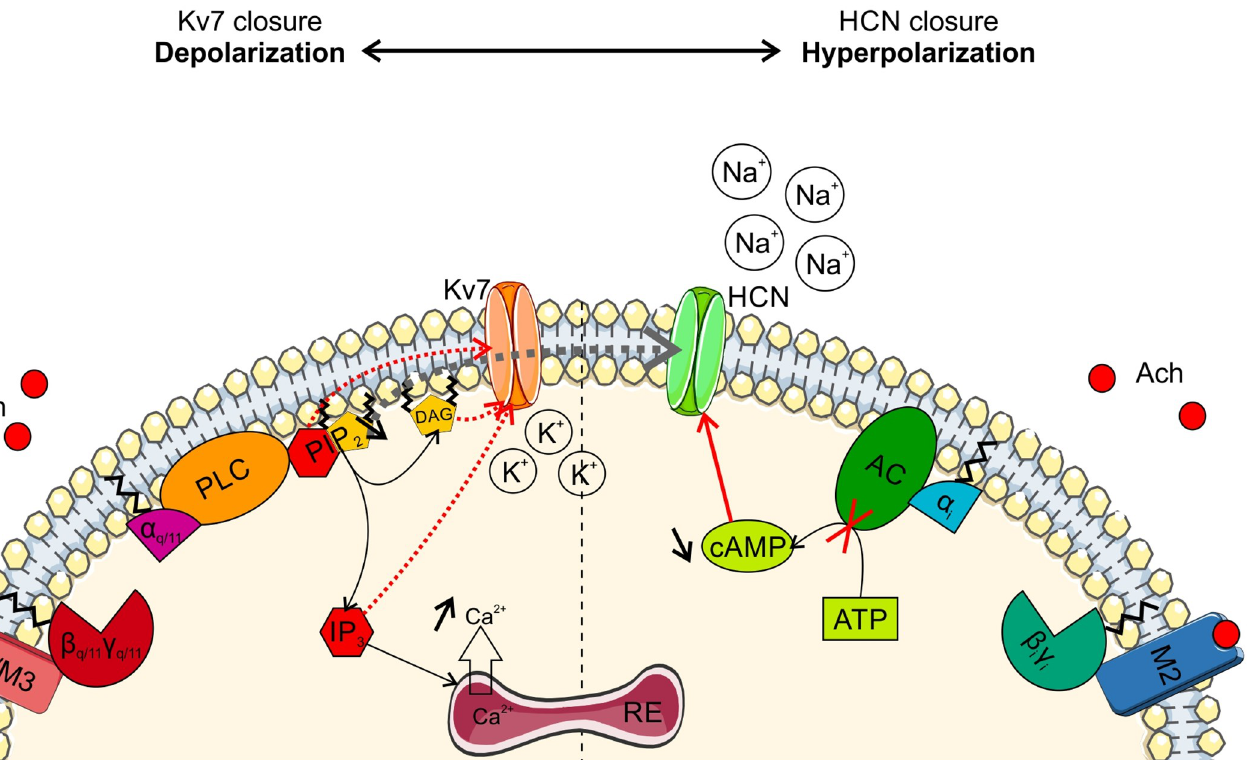
PLOS ONE | https://doi.org/10.1371/journal.pone.0226954 January 15,